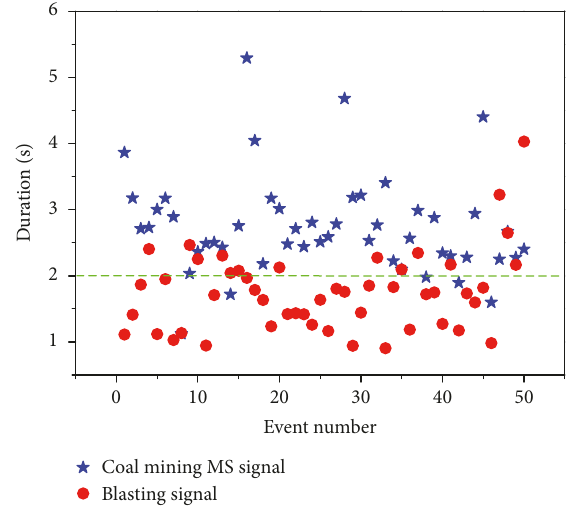
Figure 2: Distribution of the dominant frequency of coal mining MS and blasting signals.